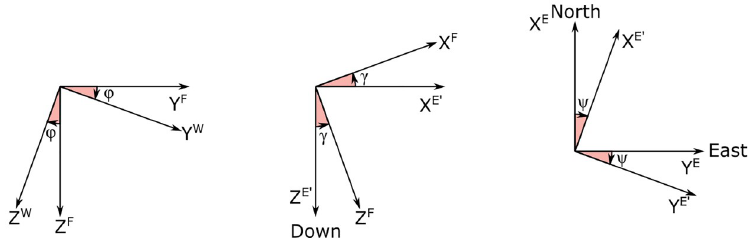
( ϕ ), T ( γ ), T ( ψ ), that define the Wind (W), Path (F) x y z